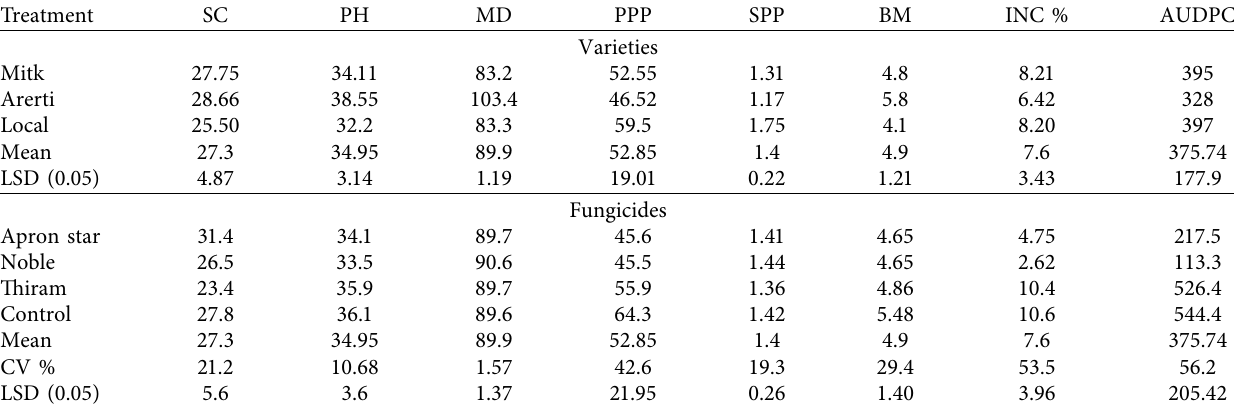
Table 4: Effect of seed dressing fungicides and chickpea varieties on seed yield, growth parameters, and on fusarium wilt disease epidemics at Sekota zuria district (woleh).